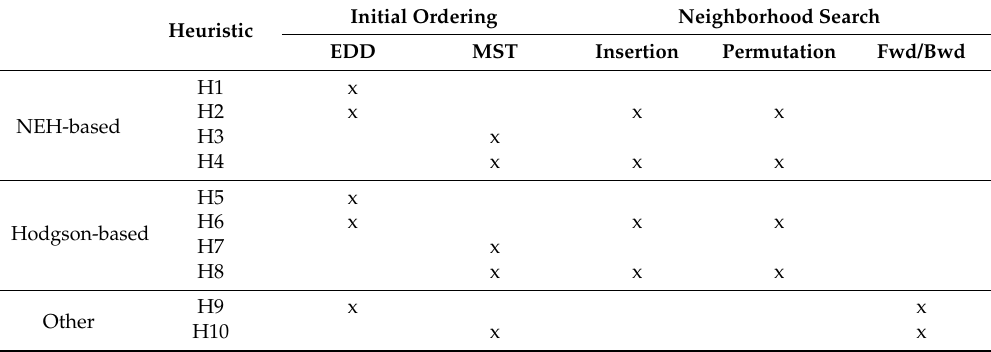
Table 2. Composition of heuristic’s